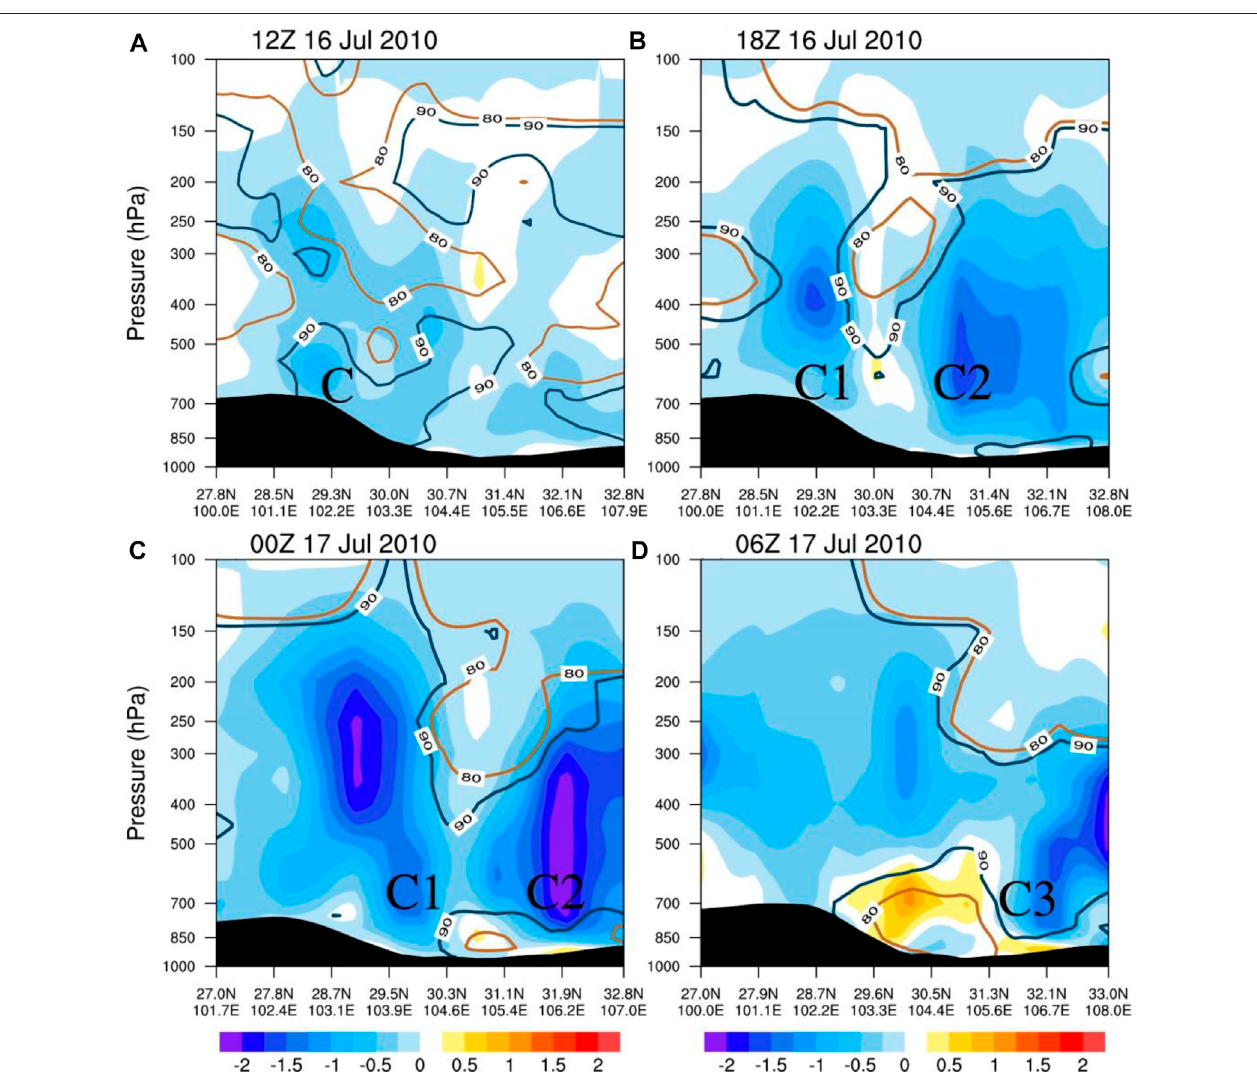
FIGURE 6 | Vertical cross-section of the vertical velocity (Pa s − 1 , shaded) and the relative humidity (%, contours) at (A) 12:00 UTC July 16, (B) 18:00 UTC July 16, (C) 00:00 UTC July 17, and (D) 06:00 UTC July 17.